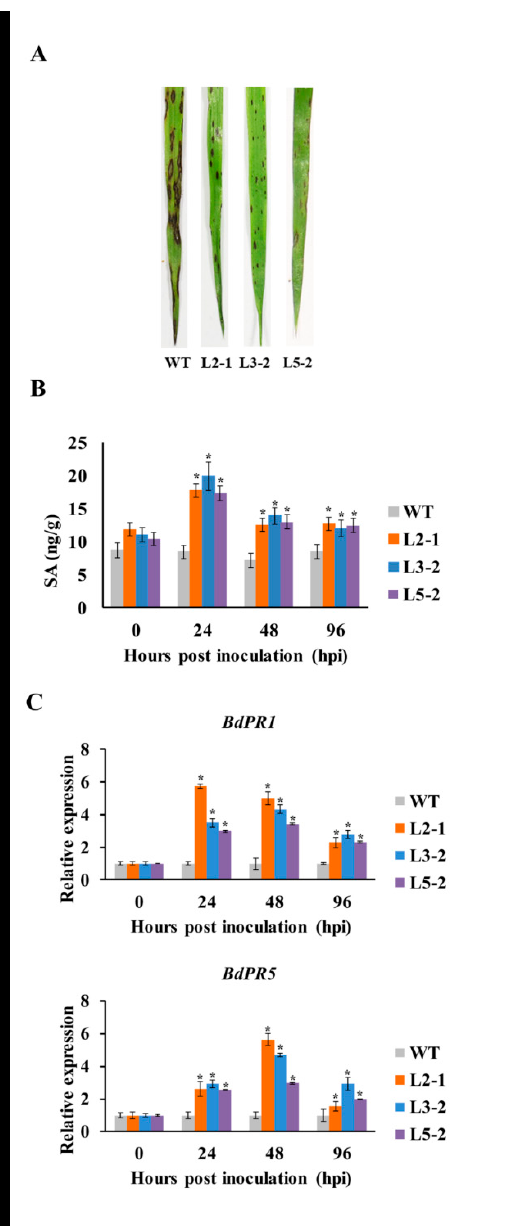
Figure 5. AtSAG101 transgenic plants produce resistance to Magnaporthe oryzae. ( A ) Phenotypic changes in leaves of AtSAG101 transgenic plants challenged with M. oryzae. ( B ) Salicylic acid (SA) accumulation in AtSAG101 transgenic leaves infected with M. oryzae . ( C ) qRT-PCR detection of PR gene expression in AtSAG101 -overexpressing B. distachyon leaves inoculated with M. oryzae . PR , pathogenesis-related gene; WT, wild type plants; L2-1, L3-2 and 5-2, transgenic B. distachyon plants; B. distachyon ( Bd ) PR1 gene (upper panel) and BdPR5 gene (lower panel). Significant di ff erences were determined using Student’s t -test: *, p <